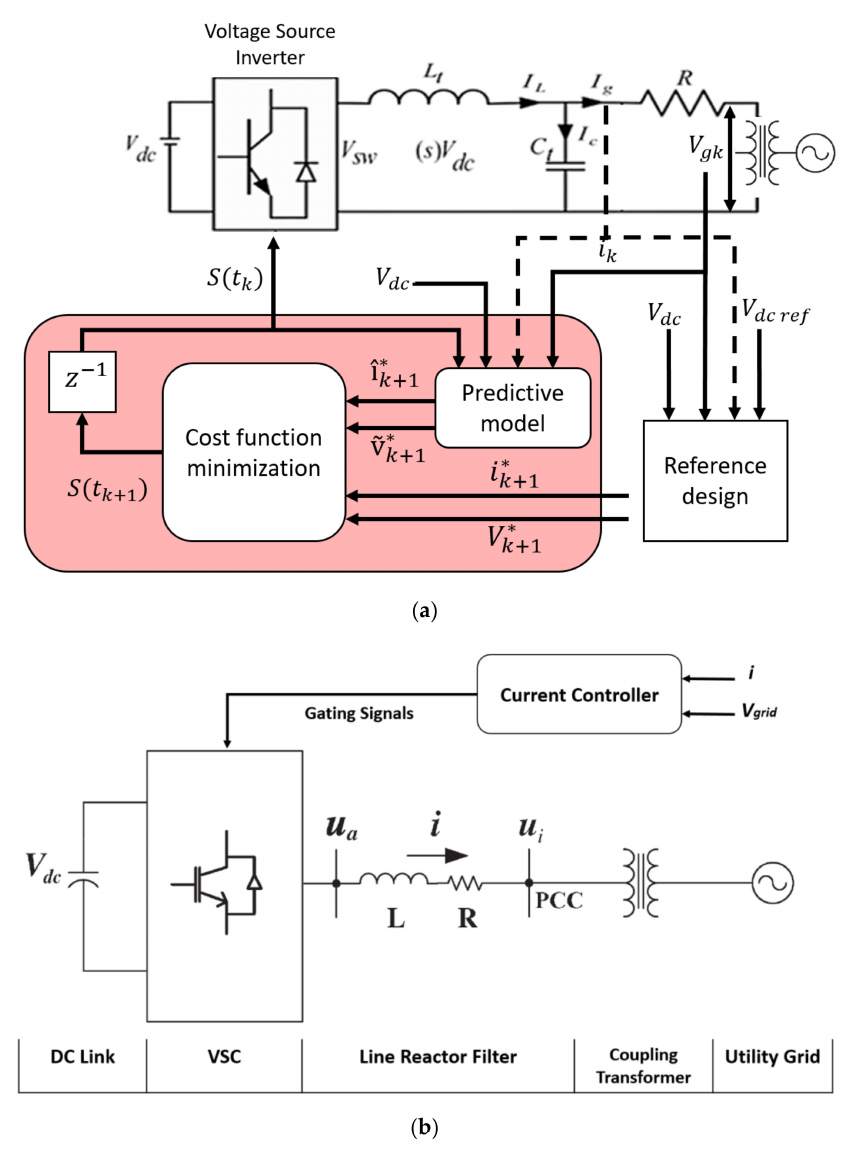
Figure 6. ( a ) Single-phase MG system, ( b ) the test system with one-line